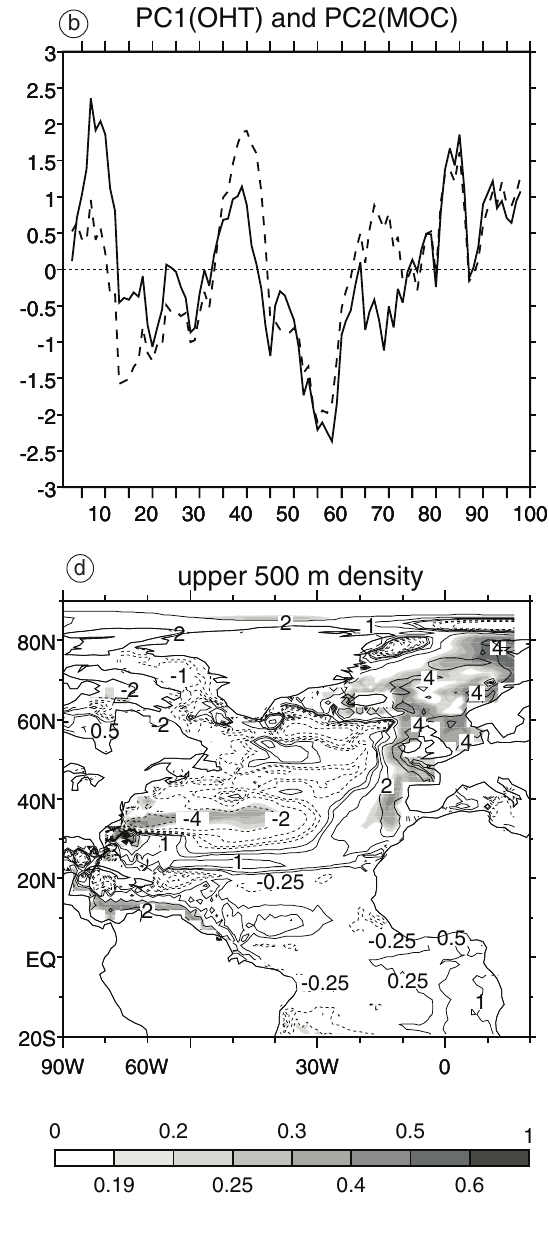
Fig. 2a-e. a) EOF1 (PW: 10 15 W), and (b) PC1 (solid line) of low frequency OHT for the HadCM3 simu- lation. Panel (b) also shows (dashed line) PC2 of low frequency MOC. c) Regression pattern of the MOC at lag 0 on PC1 of low frequency ocean heat transport (unit: Sv per unit of PC1 of OHT). d) Regression coefficients of the upper ocean (500 m) density (10 − 5 g cm − 3 ) to PC2 of the MOC at lag 0. e) Normalized time series of PC2 of the MOC and the density index defined over the deep convection region. Shading scale in (c) and (d) indicates explained local